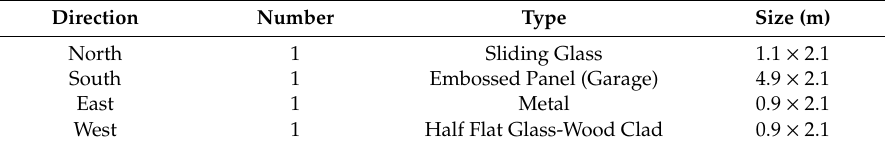
Table 5. Exterior doors characteristics.